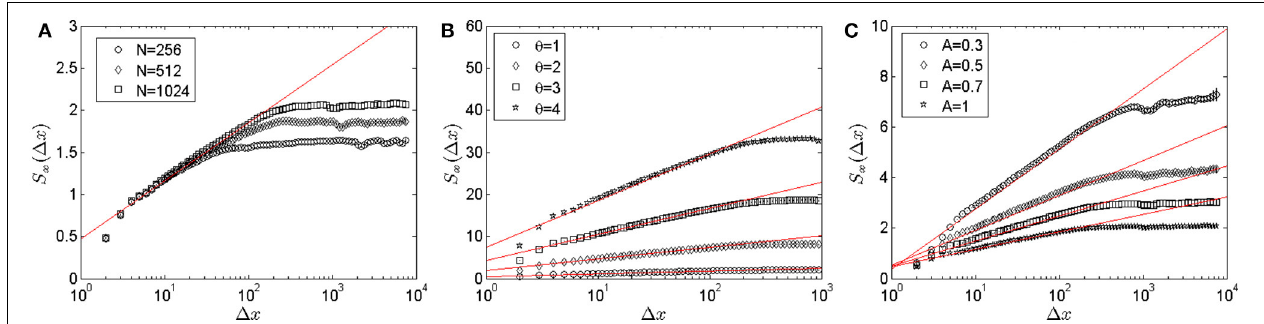
FIGURE 11 | Structure function S x ( (cid:4) x ) measured along x (A) for various system sizes N at A = 1 and ˜ θ = 1, (B) for various ˜ θ at A = 1 and N = 1024, and (C) for various A at constant ˜ θ = 1 and N = 1024. The ordinate axis is logarithmic. For all figures, the straight lines correspond to the solutions of Equation 15.